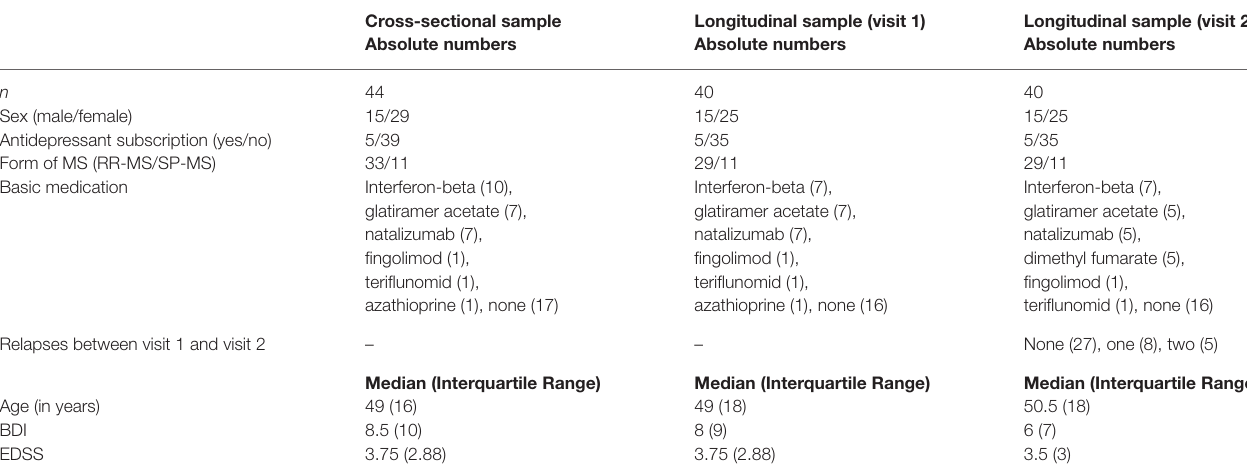
TABLE 1 | Characteristics of patients included in the cross-sectional and longitudinal